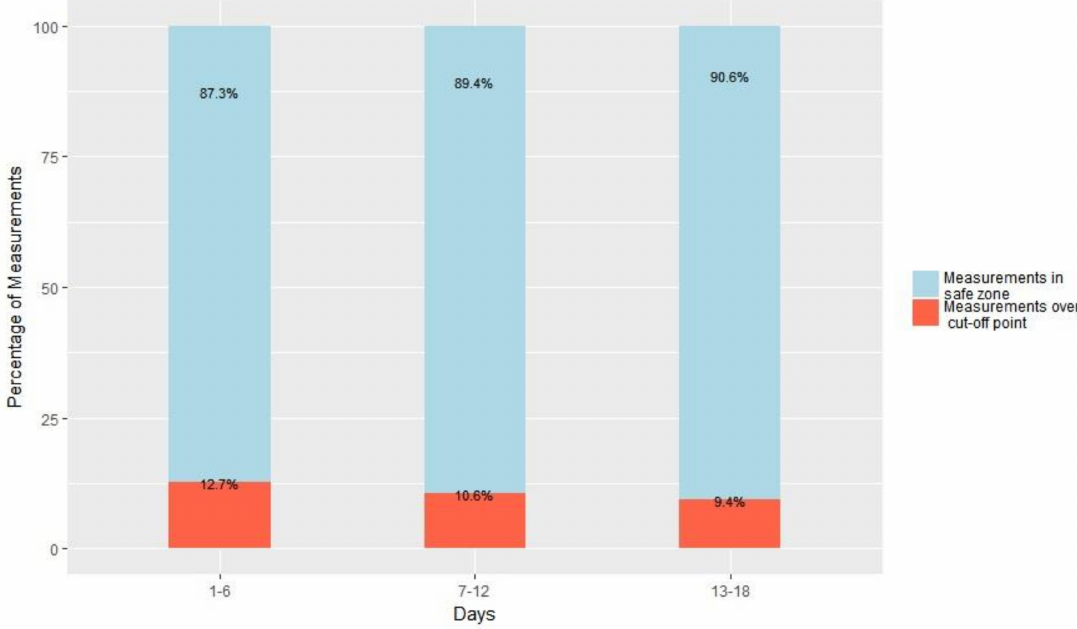
Figure 13. Measurement percentage within the parameters established as being safe for the following physiological constants grouped together into 6-day